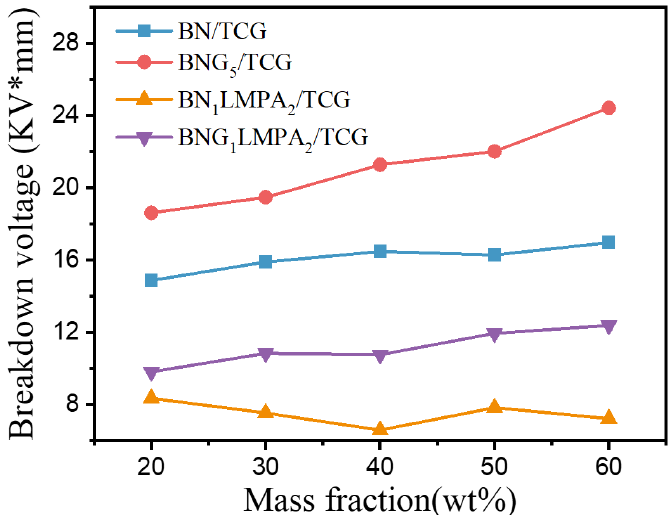
Figure 6. Breakdown voltages of different TCG. Table 2. Volume resistivity of different TCG.